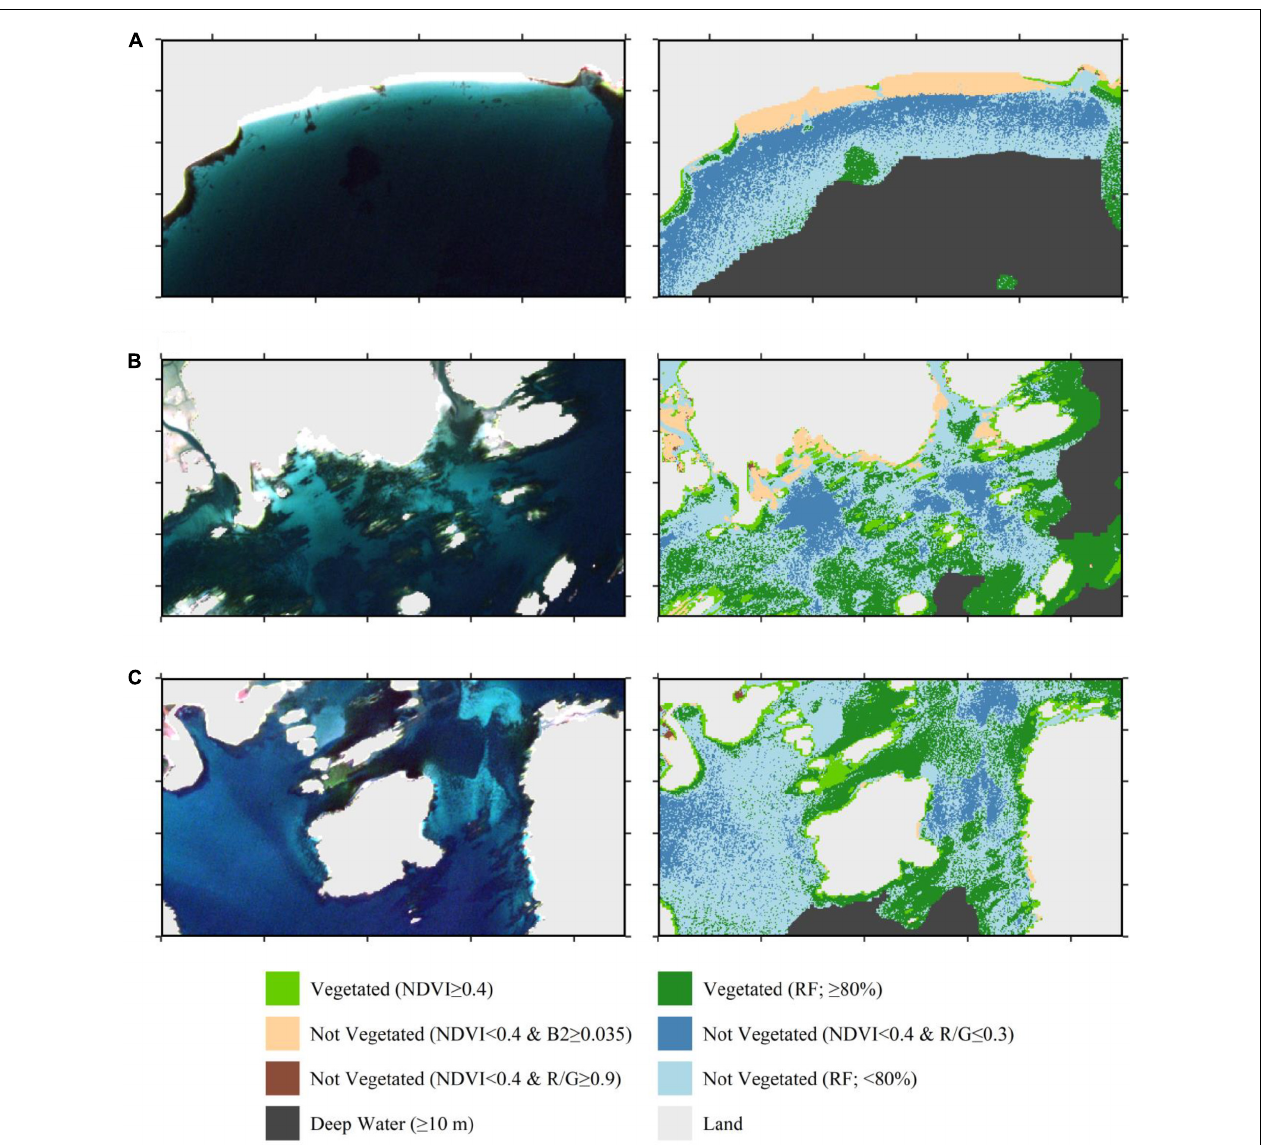
FIGURE 5 | Finalized classification of the Sentinel-2 image from September 13, 2016 highlighting three example regions where the classification performed well including the differences between the classification stages. Left column is the true color composite. Right column is the map classification for the same region. (A) A predominantly sandy beach with distinct seaweed patches (F5A in Figure 4 ). (B) Mixed seaweed and eelgrass habitat interspersed with sandy habitat (F5B in Figure 4 ). (C) Large dense eelgrass meadows and separate kelp forests surrounded by bare substrate (F5C in Figure 4 ). Knowledge of vegetation type was from the field survey data only and not the map